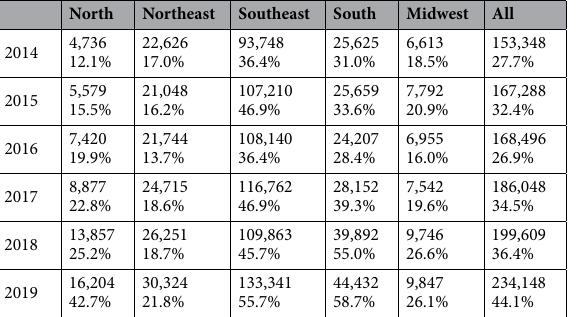
Table 2. Number of procedures and coverage of Diabetic Retinopathy Treatment among Diabetic Patients through SUS from 2014 to 2019 according to the region. First row: Number of diabetic retinopathy treatment procedures. Second row: Diabetic Retinopathy Treatment Coverage.